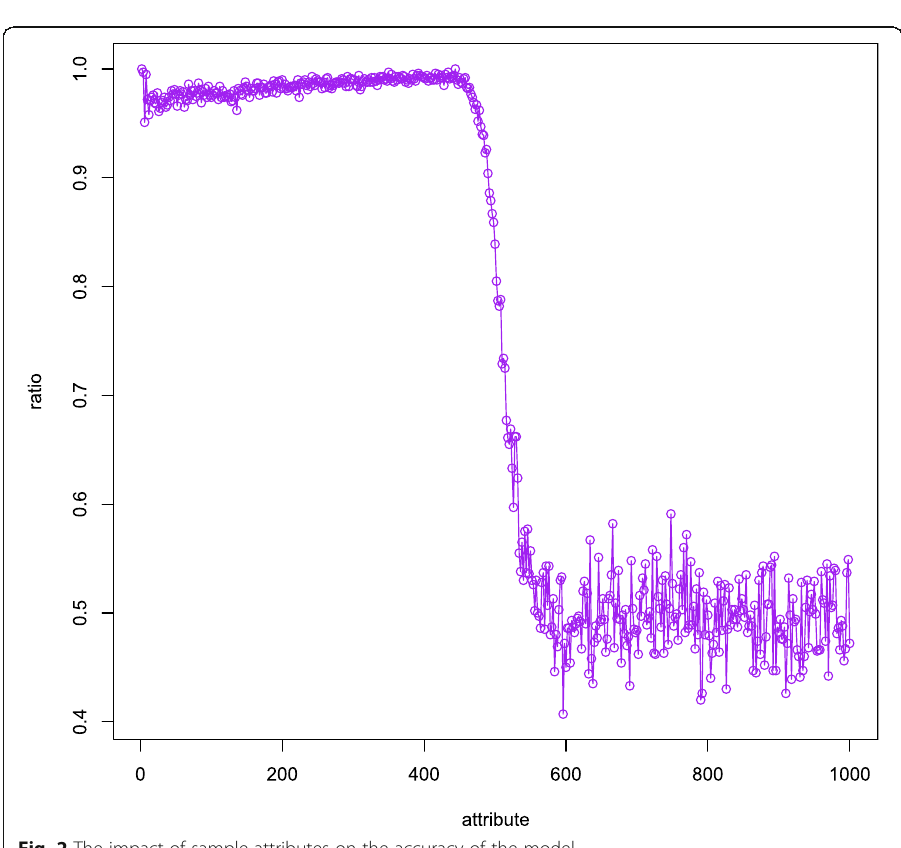
Fig. 2 The impact of sample attributes on the accuracy of the